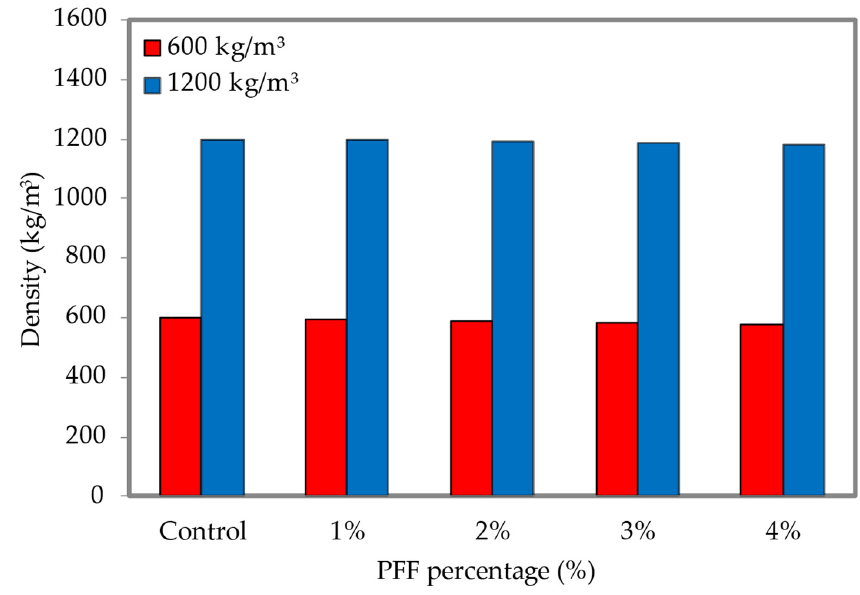
Figure 9. Density of foamed concrete with varying percentages of PFF.